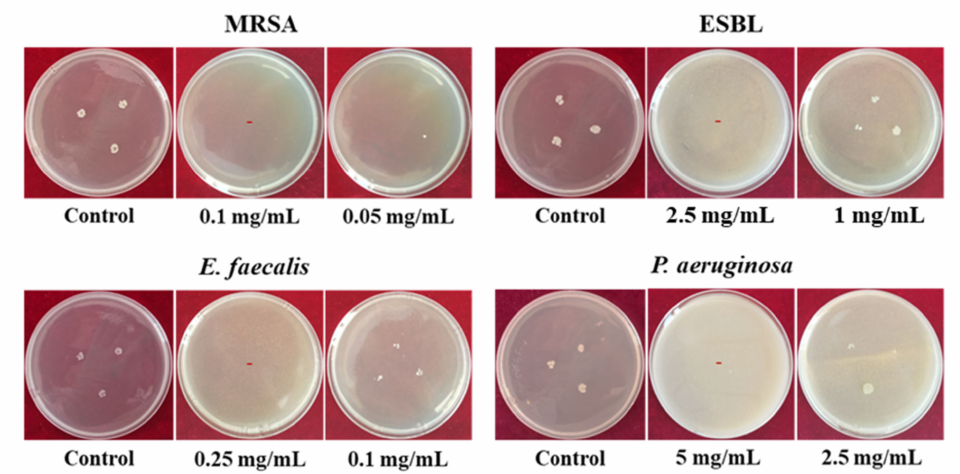
Figure 6. MIC values of MAG/C–ZnO/APT-2.5%nanocomposite toward MRSA, ESBL- E. coli , E. faecalis and P. aeruginosa . The red “-” denotes no bacteria in the plates.